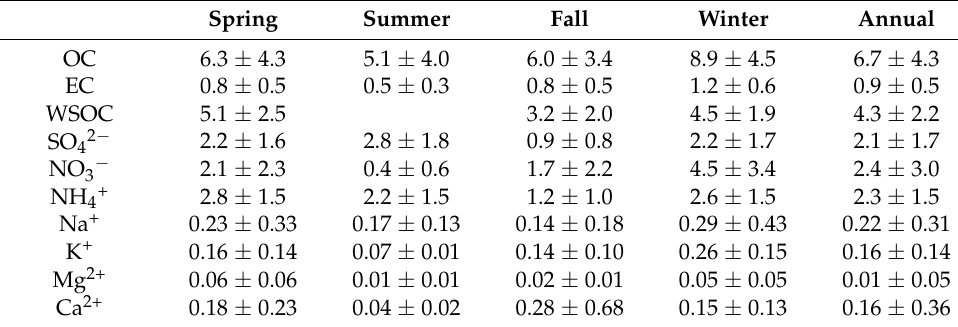
Table 2. Seasonally averaged PM 2.5 constituent concentrations ( µ g m − 3